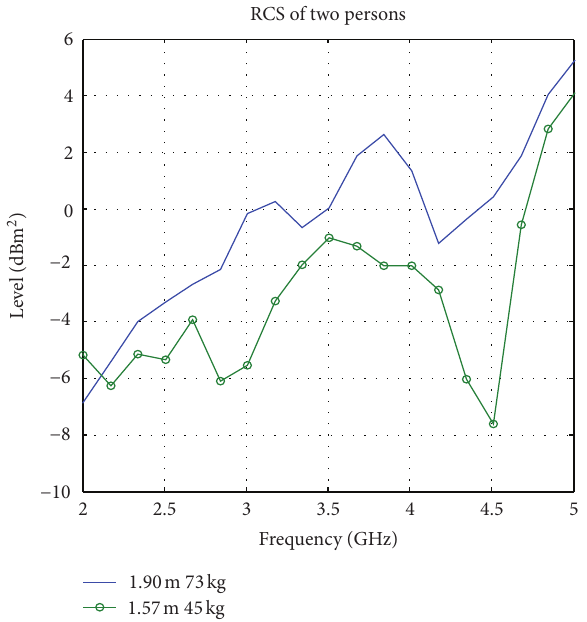
F 6: Radar cross-section of two different